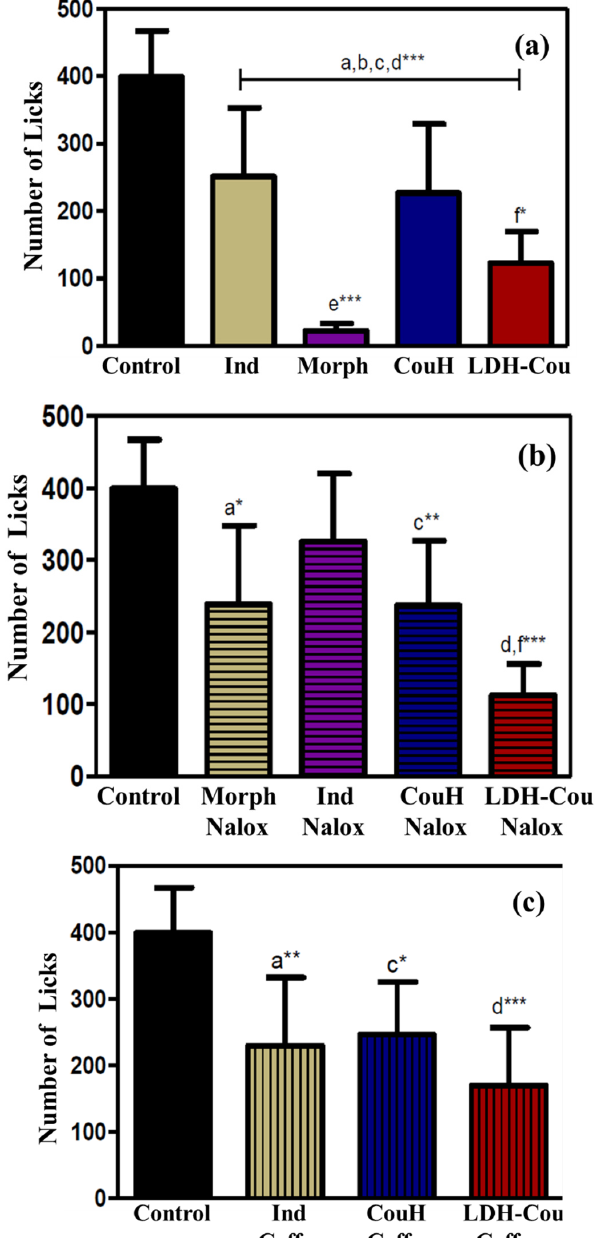
Figure 7. Formalin assay response, from 15 to 30 min. ( a ) Groups without association; ( b ) groups associated with naloxone (Nalox); ( c ) groups associated with caffeine (Caffe). Statistical analysis with significance set at *** p < 0.001; ** p < 0.01; and * p < 0.05 (ANOVA), where a—Ind vs. control; b—Morph vs. control; c—CouH vs. control; d—LDH-Cou vs. control, e—Morph vs. Ind; and f—CouH vs. LDH-Cou.